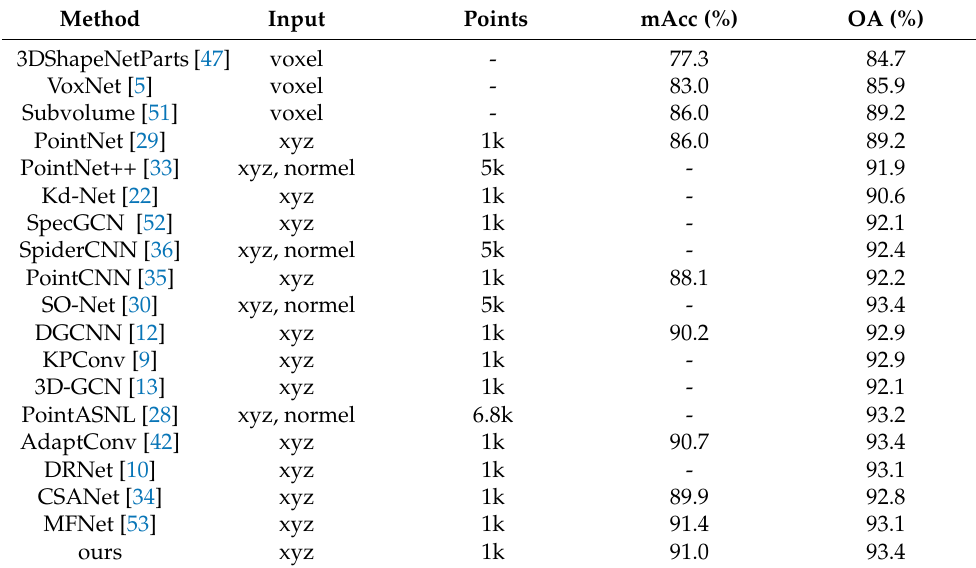
Table 1. Classification results on ModelNet40 dataset.